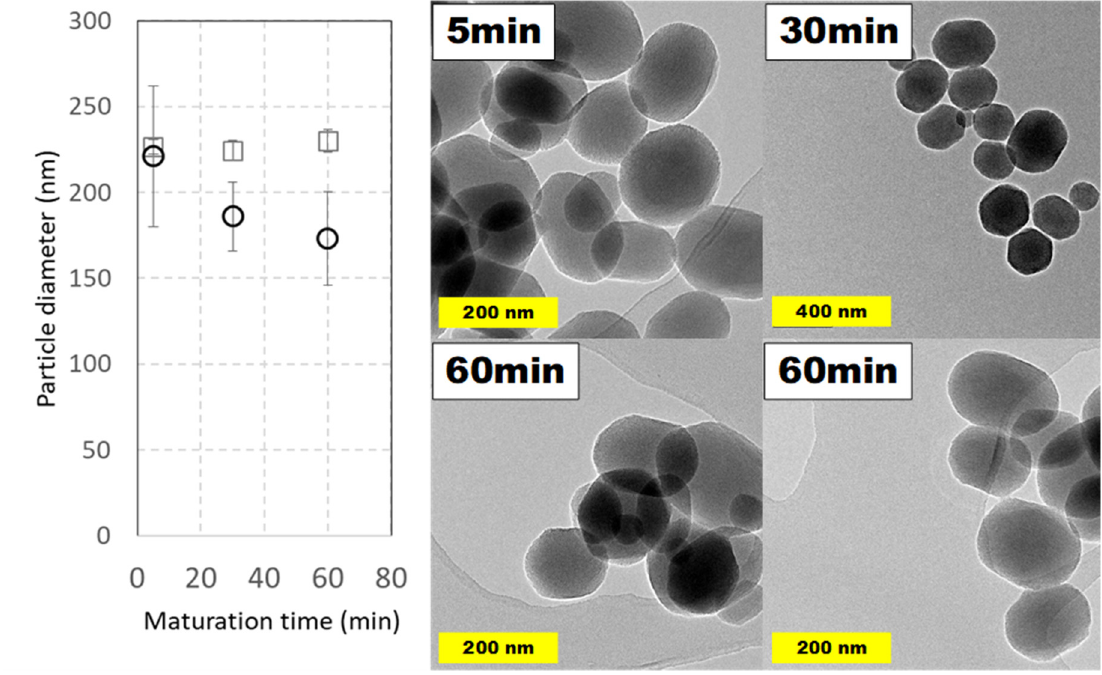
Figure 8. Particle size distributions and TEM images of MCM-41 MSNs prepared in pilot-plant scale at several reaction times. Squares ( ) are used for hydrodynamic diameters measured by DLS values and circles ( ) for diameters measured on TEM micrographs. Experimental conditions: 5 L jacketed cylindrical reactor with 4 L working volume with a Rushton turbine as overhead stirrer (650 rpm). Reactions were carried out at 60 °C using TEOS (40 mL, 4 mL·min -1 ) and CTAB (8 g, 2 g ⋅ L -1 ) during indicated times. Data shown correspond to samples 359.2 in Supplementary Materials.